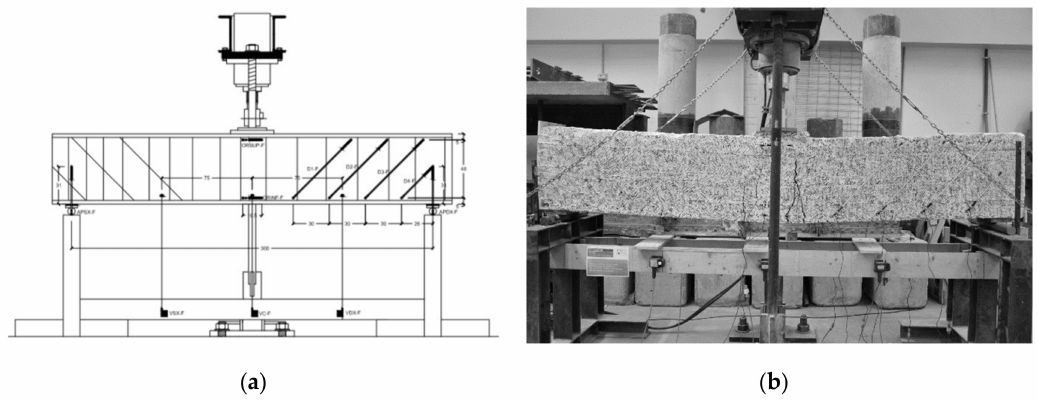
Figure 11. ( a ) Test set-up of the BEAM specimen; ( b ) failure mechanism in bending.